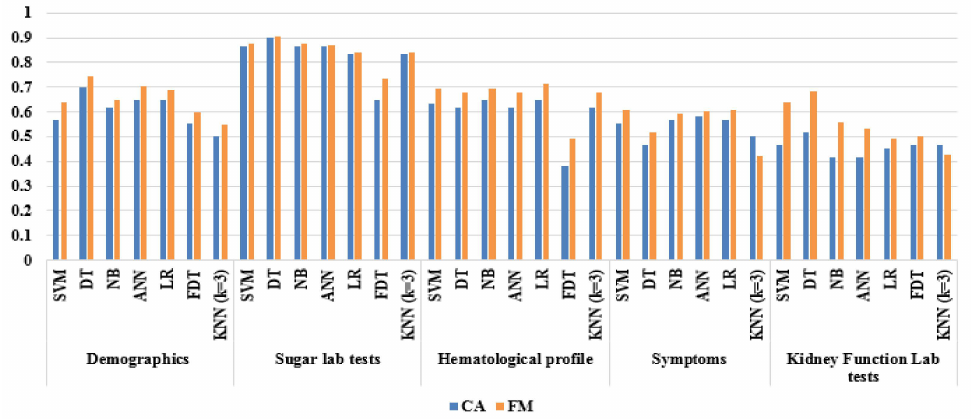
Figure 4. A comparison between CA and FM for base classifiers using CFS (part 1).